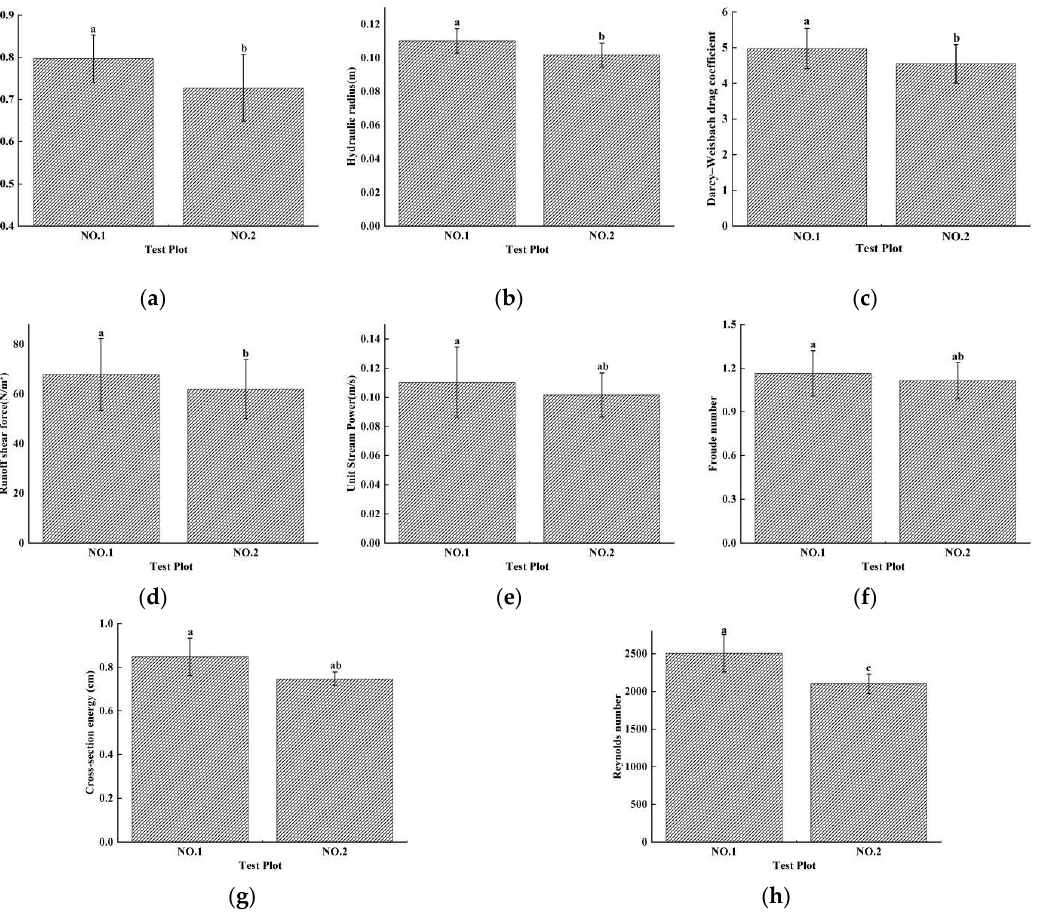
Figure 8. Total velocity ( V ) ( a ), Hydraulic radius ( R ) ( b ), Darcy-Weisbach drag ( DW-f ) ( c ), Runoff shear force ( τ ) ( d ), Unit stream power ( P ) ( e ), Froude number ( Fr ) ( f ), Cross-section energy ( ε ) ( g ) and Reynolds number ( Re ) ( h ) in short-term heavy rainfall (No. 1 plot) and moderate rainfall (No. 2 plot) experiments.